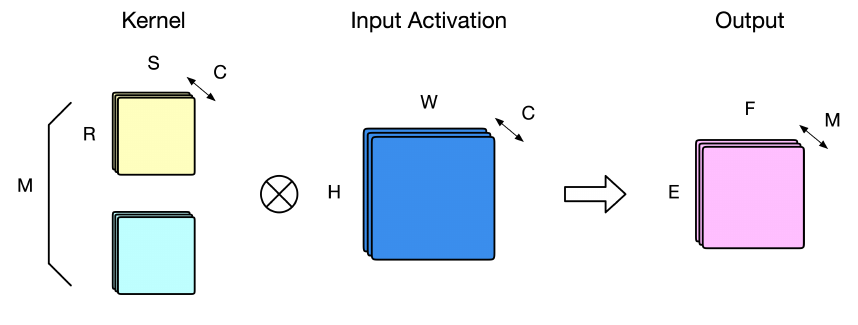
Figure 1. Concept of convolution neural